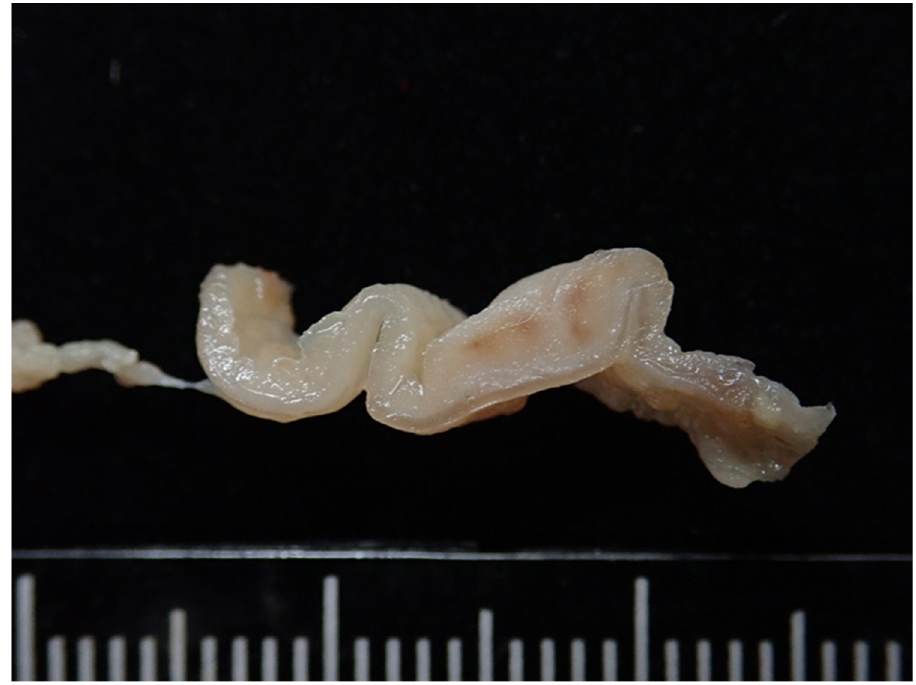
Figure 4. Gastric mast cell tumor, African dormouse, Stomach. The cross-section of the fixed stomach tissue revealed thickened tan-colored, firm mucosal layer.